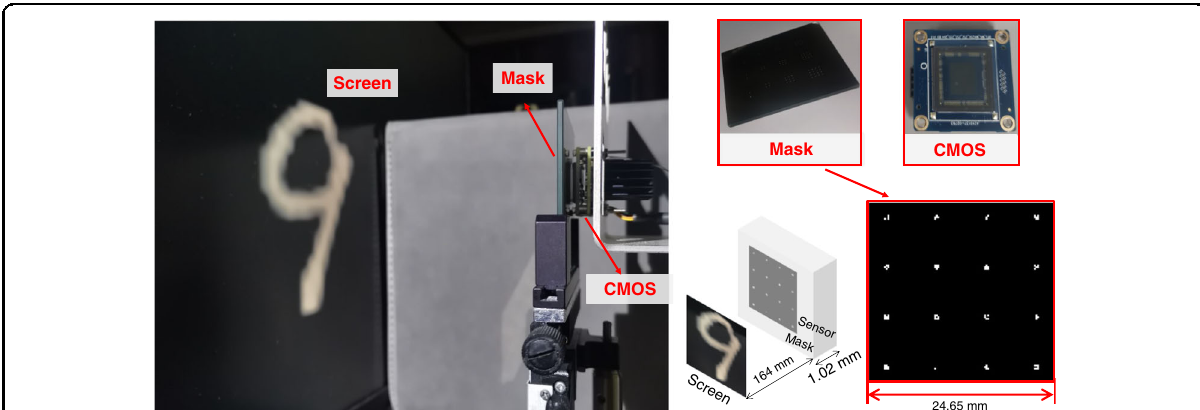
Fig. 4 LOEN prototype for single-kernel and multiple-kernel systems. Prototype consists of a Sony IMX264 sensor with an optical mask placed approximately 1 mm from the sensor